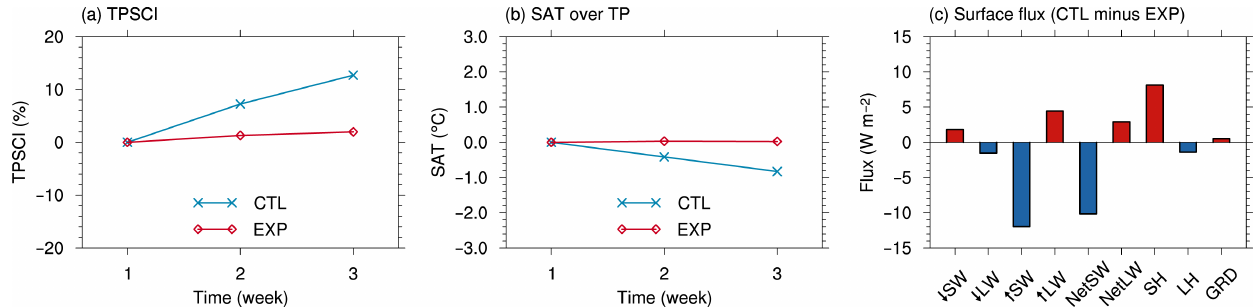
Figure 11. Sensitivity of SAT and surface energy balance to TPSC biases in the numerical experiments. (a) TPSCI and (b) SAT over the Tibetan Plateau in the CTL (blue lines) and EXP (red lines) runs. The units of TPSCI and SAT are percent (%) and degree Celsius ( ◦ C). The x axis represents the number of weeks lagging the start of the model initial date (unit: week). (c) The difference in the surface energy balance between the CTL and EXP runs (CTL minus EXP) at 3 weeks in the numerical experiments. The terms from left to right are downward shortwave radiation ( ↓ SW), downward longwave radiation ( ↓ LW), upward shortwave radiation ( ↑ SW), upward longwave radiation ( ↑ LW), net shortwave radiation (NetSW), net longwave radiation (NetLW), sensible heat flux (SH), latent heat flux (LH) and ground heat flux (GRD) at the surface over the Tibetan Plateau (unit: Wm − 2 ). The flux sign is positive